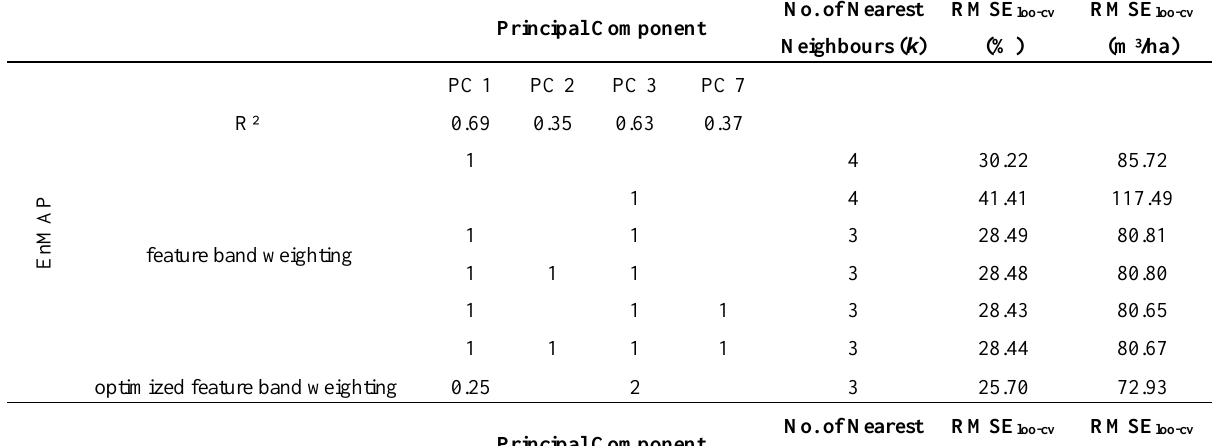
Table 2. Parameterizations of EnMAP and Sentinel-2 k -NN model.